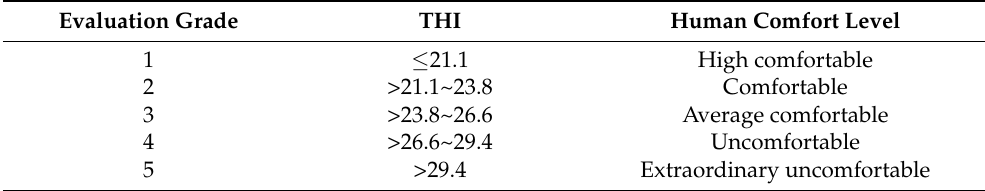
Table 1. Evaluation standard of the temperature–humidity index (THI).